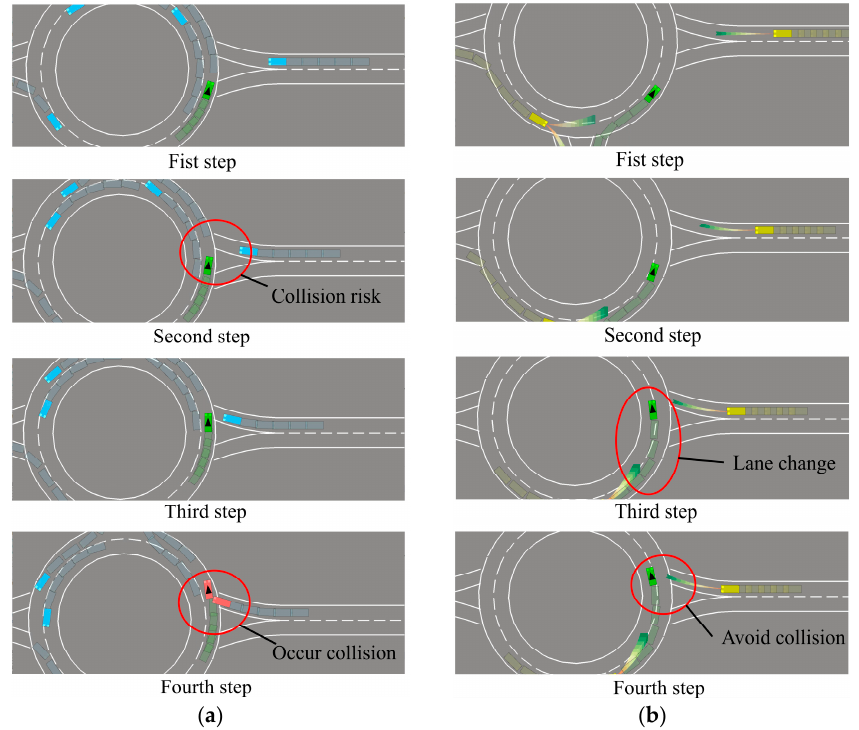
Figure 12. Comparison of SAC policy and IP-SAC policy in the case of oncoming vehicle on the right. ( a ) SAC Policy. ( b ) IP-SAC Policy.